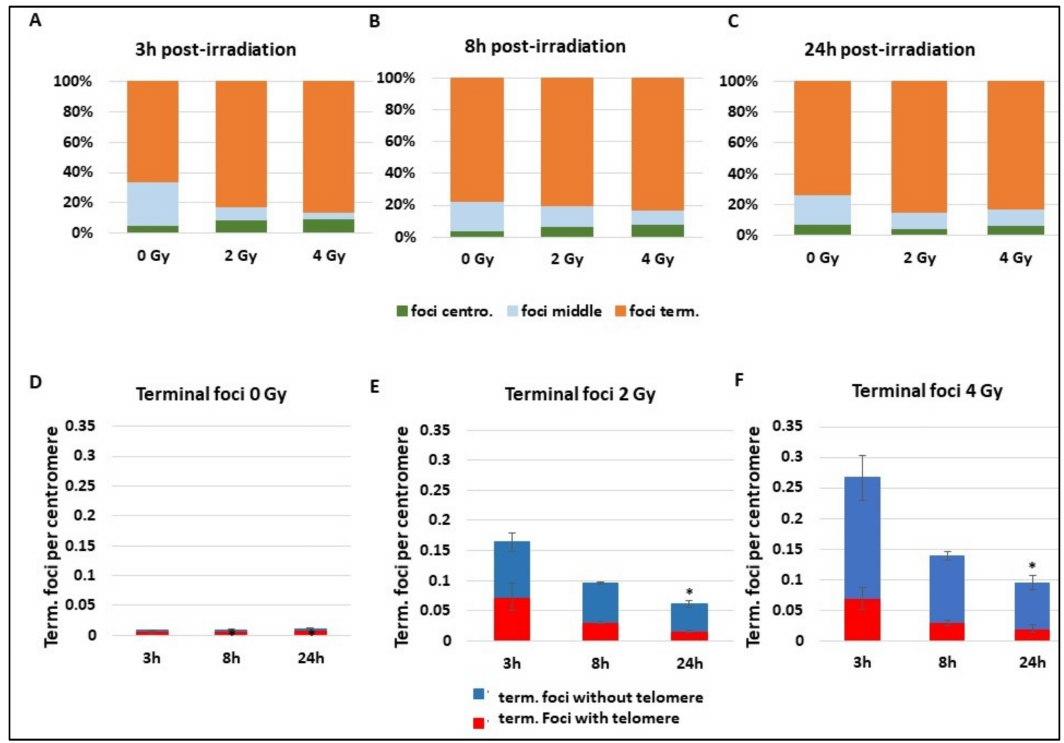
Figure 5. Localization of γ -H2AX foci on chromosomes. Blood samples from three donors were irradiated at 2 or 4 Gy or kept free from ionising radiation and then analysed using the PCC technique. ( A – C ) After immunofluorescence staining, γ -H2AX foci position on chromosome sequence was determined “close to chromosome extremities”, “close to centromere”, or “in the middle of the chromatide”. Analyses were performed at 3 h ( A ), 8 h ( B ), or 24 h ( C ) after radiation exposure. ( D – F ) Only γ -H2AX foci “close to chromosome extremities” were sub-classed in two groups, γ -H2AX foci associated “with telomeres” or “without telomere” and followed at 3 h, 8 h, and 24 h post radiation exposure. The graphs show the repartition of foci without irradiation ( D ) and after 2 Gy exposure ( E ) or 4 Gy ( F ) radiation exposition. The decrease of terminal foci without telomere is significant at 24 h ( p <